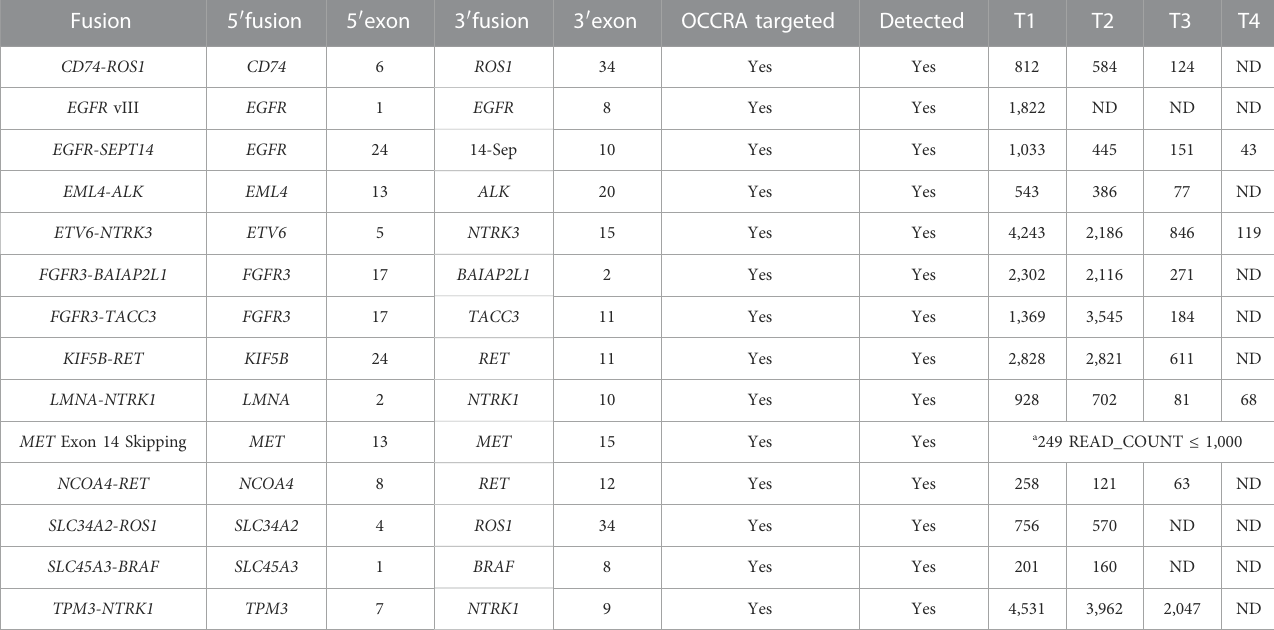
TABLE 8 Accuracy. The LOD of fusion detection. Fusion